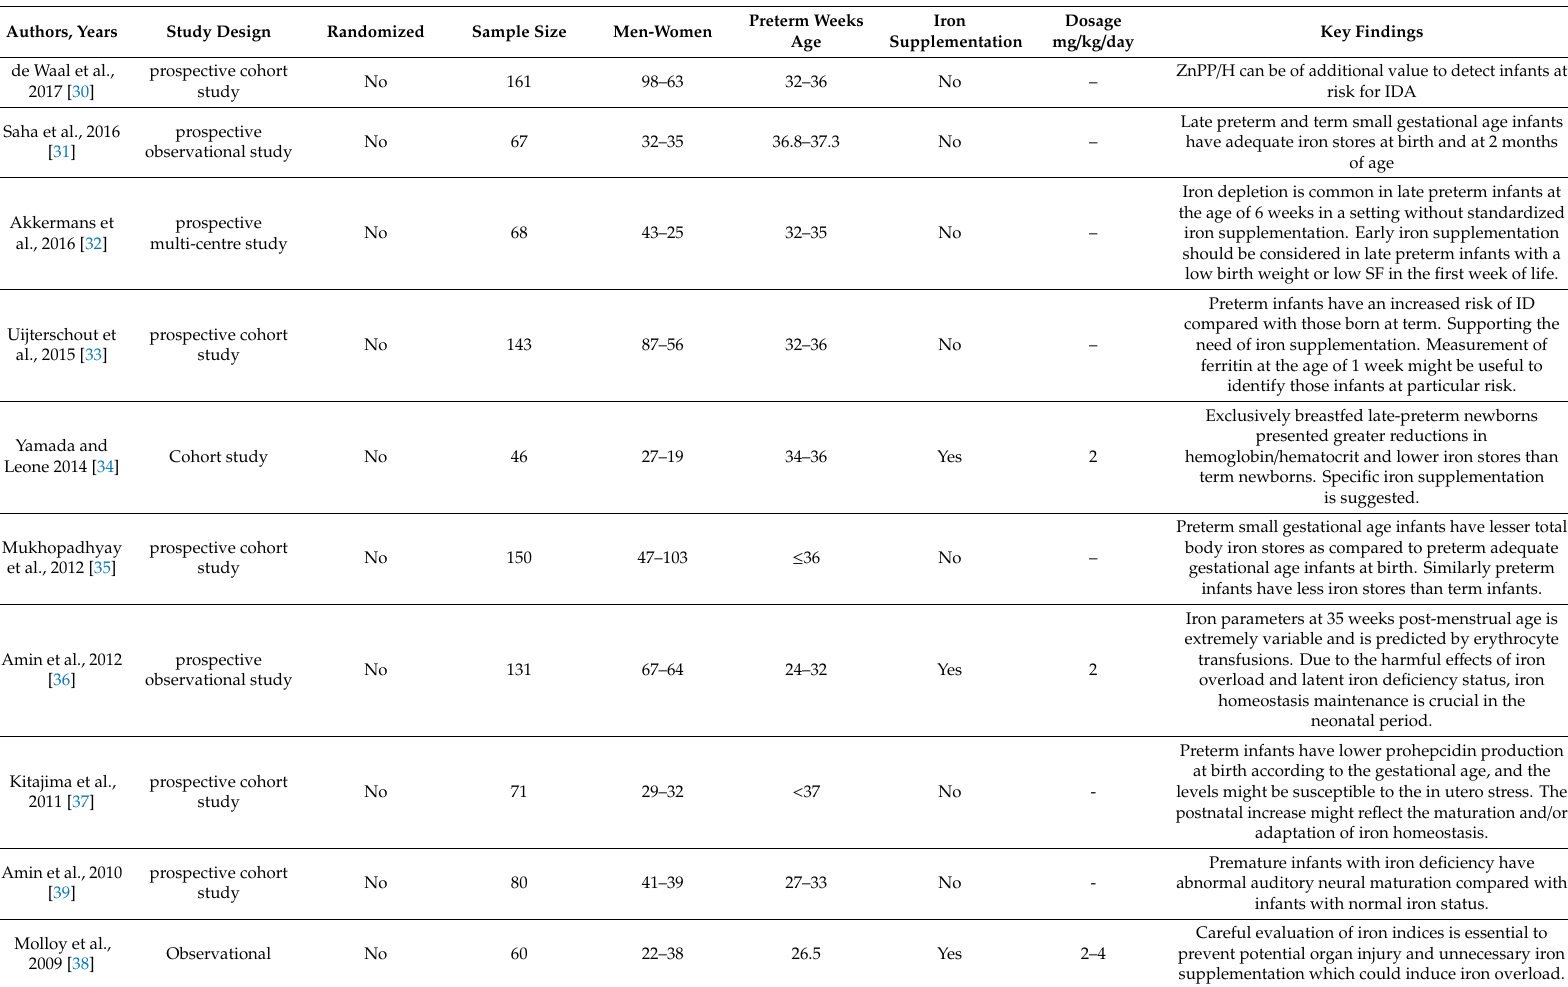
Table 4. Summary of characteristics of non- randomized studies. ZnPP / H, Zinc protoporphyrin / heme; SF, serum